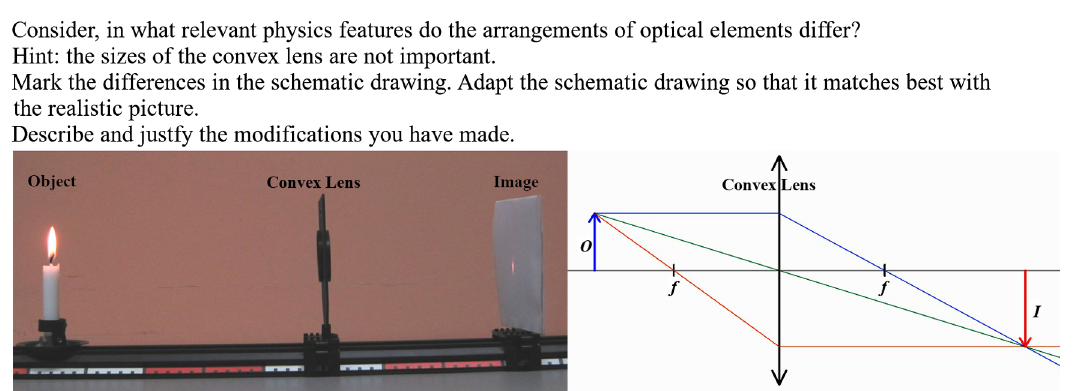
FIG. 2. RAT for fostering students ’ ability to connect several types of representations ( O ¼ object size; f ¼ focus, I ¼ image size).